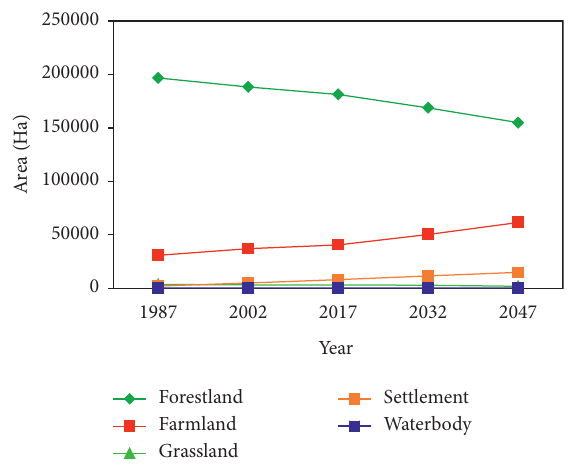
Figure 8: Trends of LULCC from 1985 to 2045 in MFBR. Table 12: Land use/land cover change key drivers and